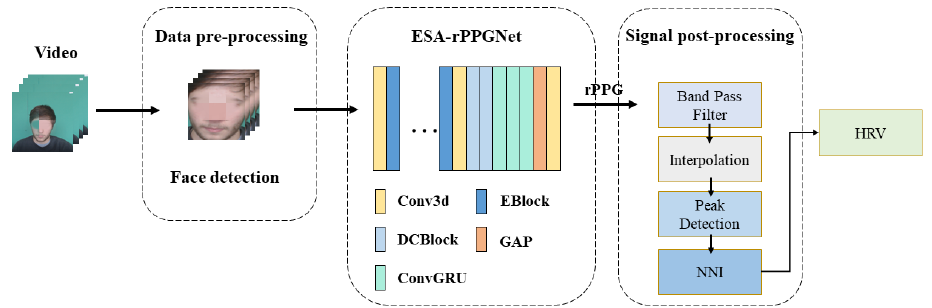
Figure 2. Proposed HRV analysis framework using